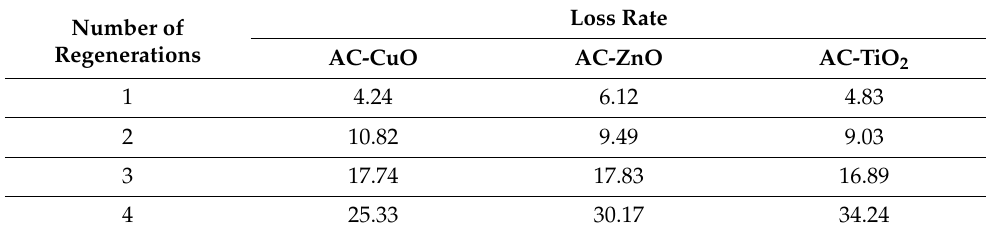
Table 8. Regeneration loss rate for the removal of methylene